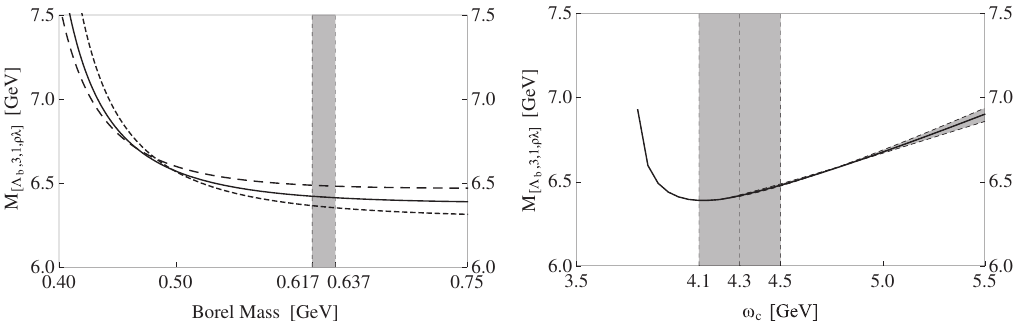
Figure 5. The variation of m Λ as a function of the Borel mass T ( left ) and the threshold value b ( 5/2 + ) ω c ( right ). In the left panel, the short-dashed, solid, and long-dashed curves are obtained by setting ω c = 4.1, 4.3, and 4.5 GeV, respectively. In the right panel the shady band is obtained by varying T within the Borel window. These figures are plotted for the bottom baryon doublet [ Λ b ( ¯3 F ) ,3,1, ρλ ]